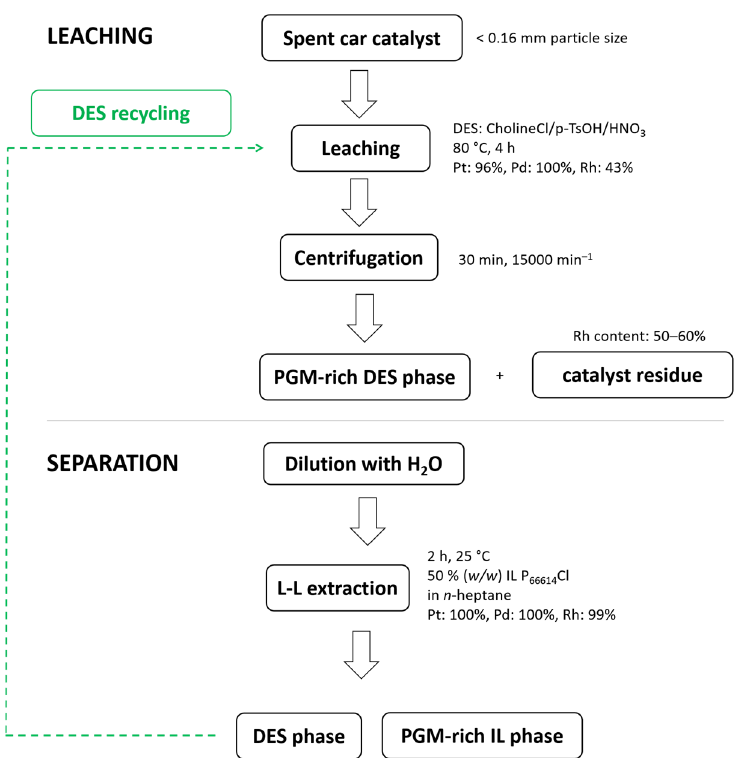
Figure 1. Flowsheet of PGM leaching and recycling processes.